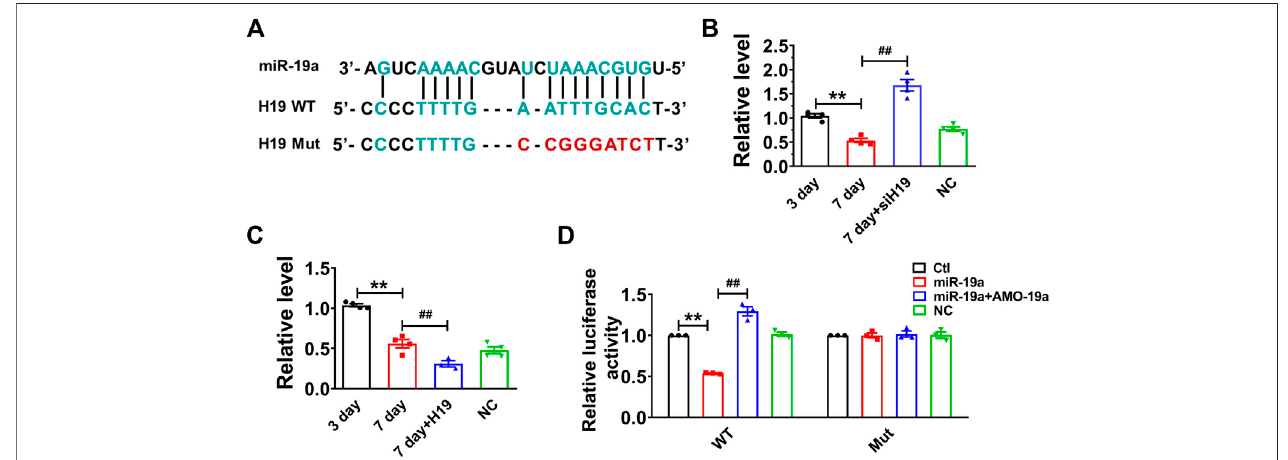
FIGURE3| H19acts asaceRNA tomiR-19aincardiomyocytes. (A) Sequence alignmentshowingthe base-pairing betweenH19 and miR-19a. (B) miR-19a was increased in siH19 group. (C) miR-19a was decreased after H19 overexpression in cardiomyocytes treated with high glucose for 7 days. (D) miR-19a strongly inhibited the luciferase activity of reporter plasmid containing H19 fragment compared with mutation group. Data are expressed as mean ± SEM, ** p < 0.01 vs. 3 days/Ctl, ## p < 0.01 vs. 7 days/miR-19a, n (cid:2) 5.